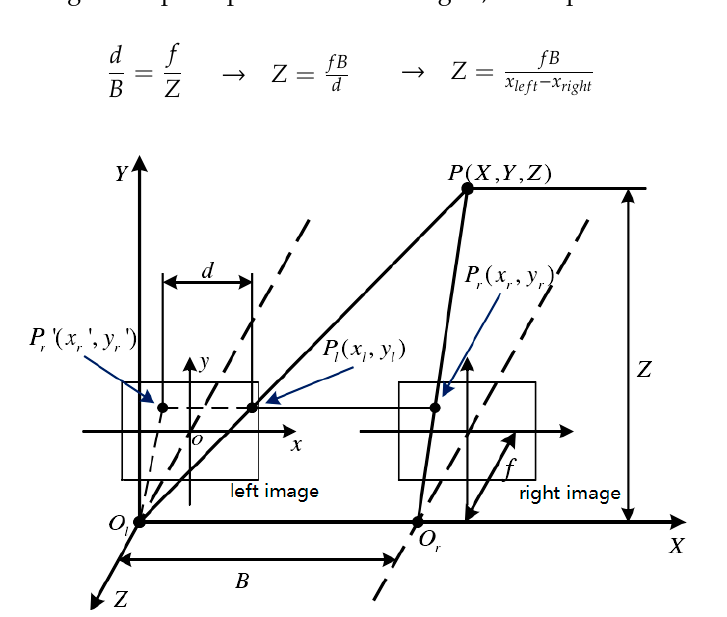
Figure 5. Depth prediction with a stereo camera.